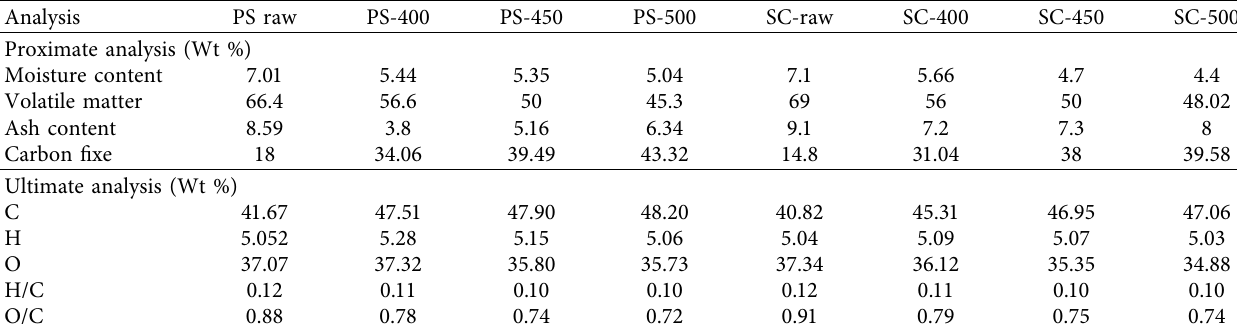
Table 2: Proximate and ultimate analysis of raw and pyrolysis